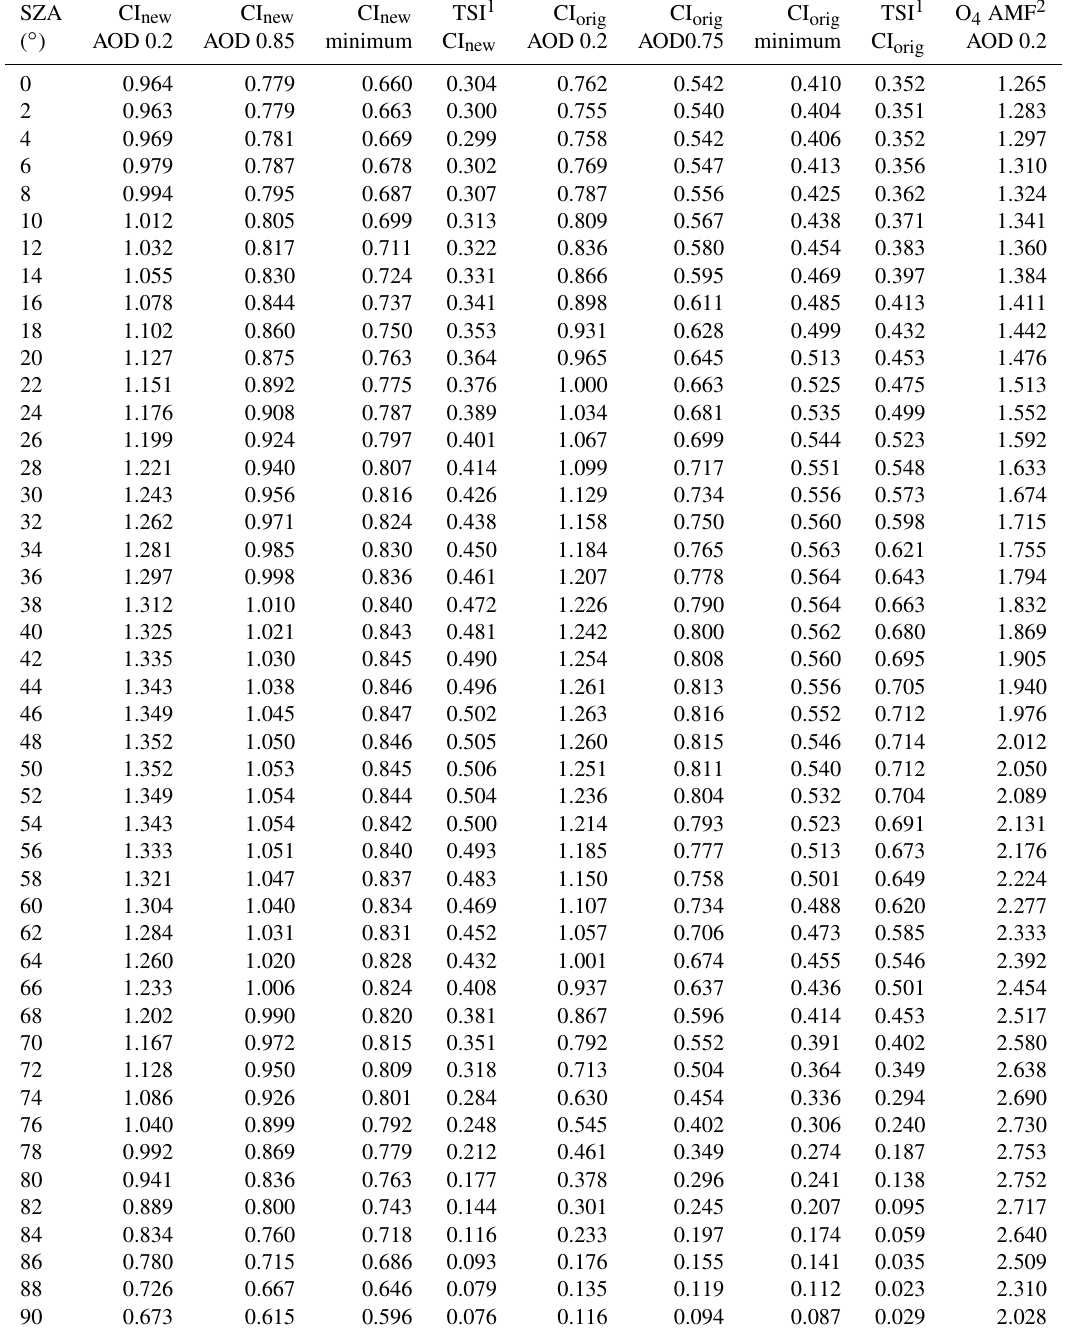
Table A1. Tabulated values for the SZA-dependent thresholds of the different